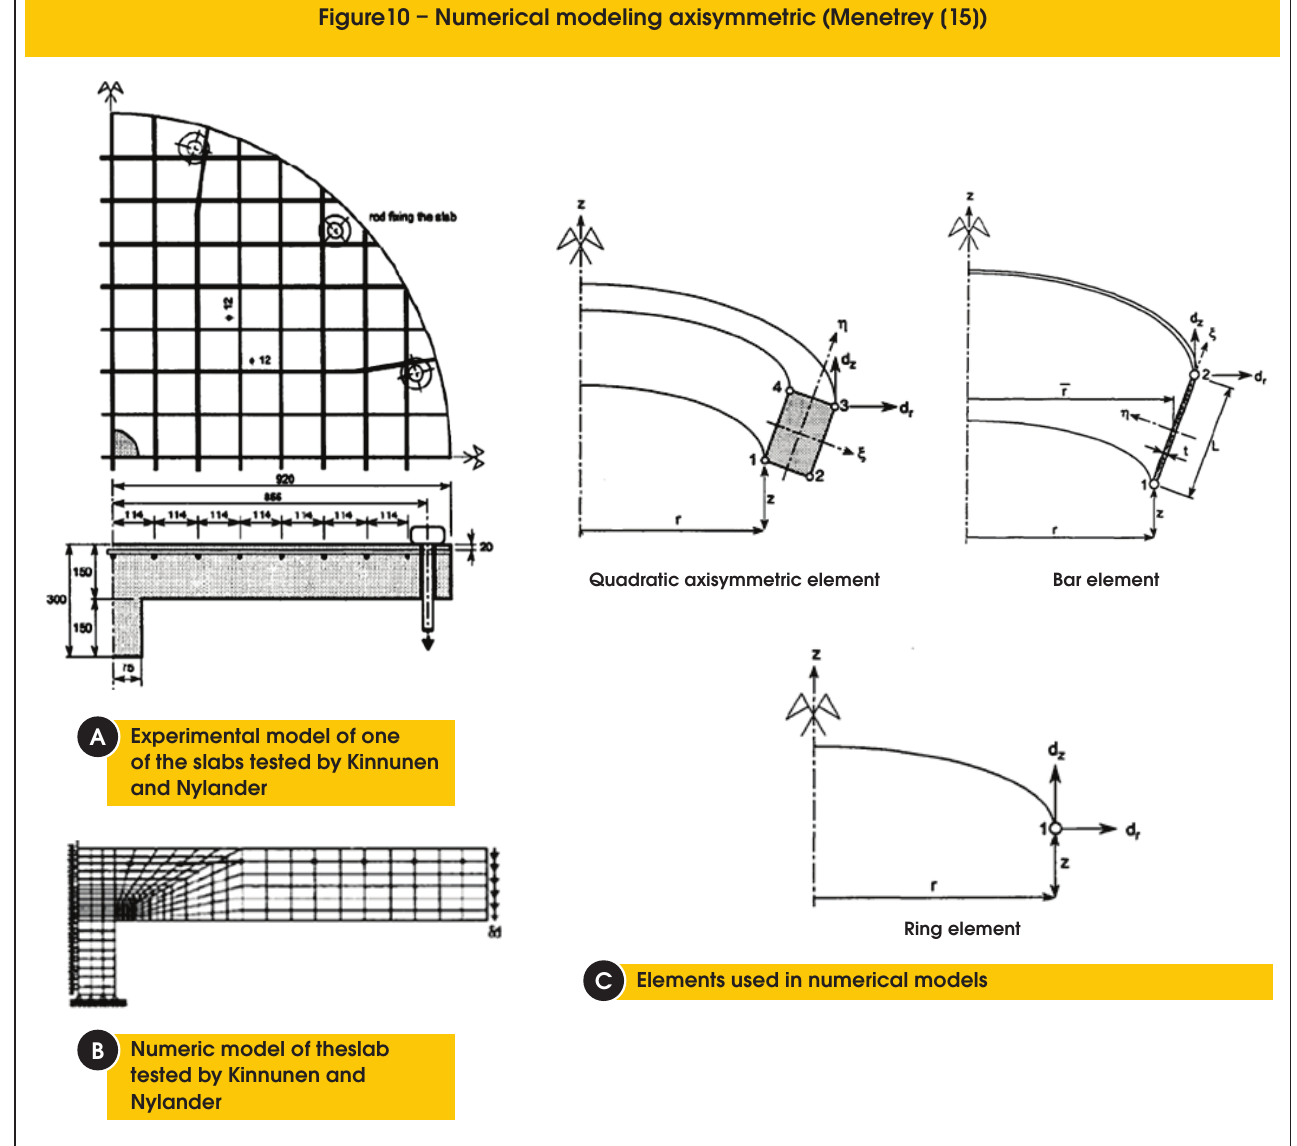
Figure10 – Numerical modeling axisymmetric (Menetrey